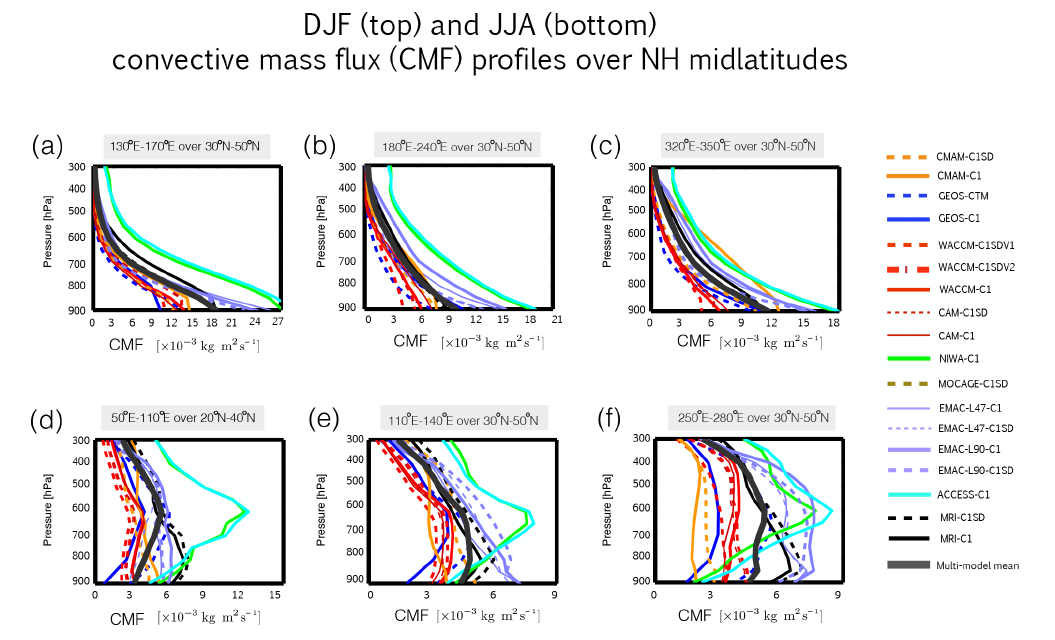
Figure 7. Vertical profiles of the convective mass flux evaluated over regions of strong midlatitude convection (black boxes in Fig. 6) during DJF (a–c) and JJA (d–f) . The thick dark grey line represents the multi-model mean and dashed lines correspond to the REF-C1SD simulations, while solid lines correspond to the free-running REF-C1